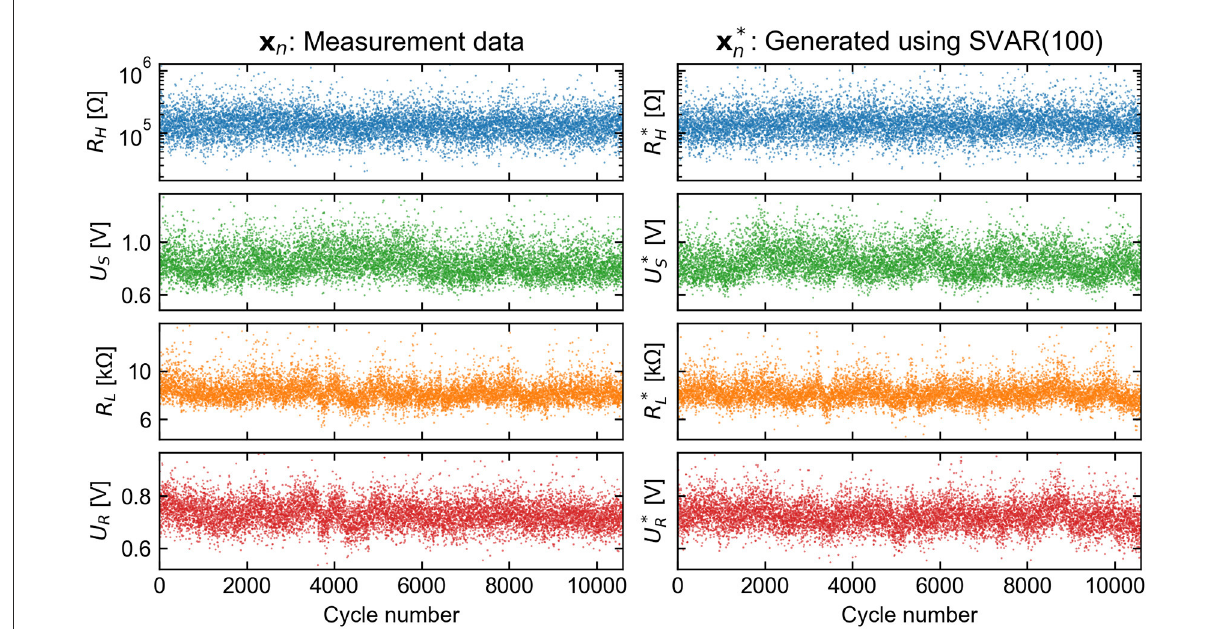
FIGURE12 Comparison of feature time series extracted from measurement data and those generated by the SVAR-based model. The compared features converge to effectively equivalent distributions and the short-range behavior is qualitatively similar across thousands of cycles.